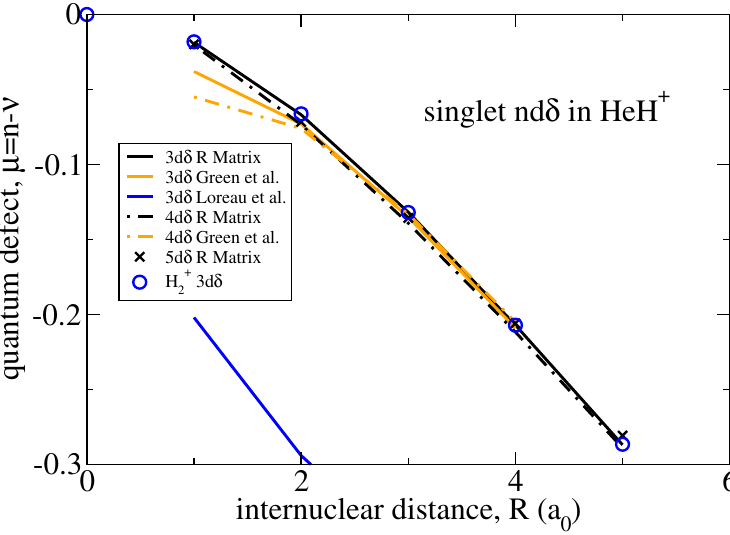
Figure 3. Quantum defects for 1 (cid:1) symmetry (˜ d (cid:5) wave) in HeH + plotted as function of the internuclear distance R for various principal quantum numbers n . The meaning of the symbols is indicated in the